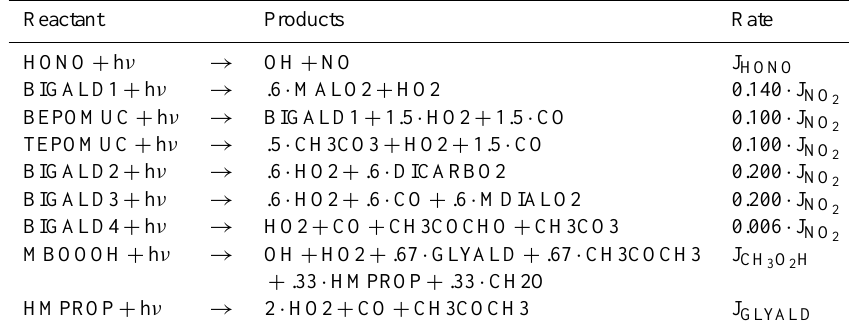
Table 5. New photolysis reactions. (J X is the photolysis rate for compound X calculated by fTUV.) Reactant